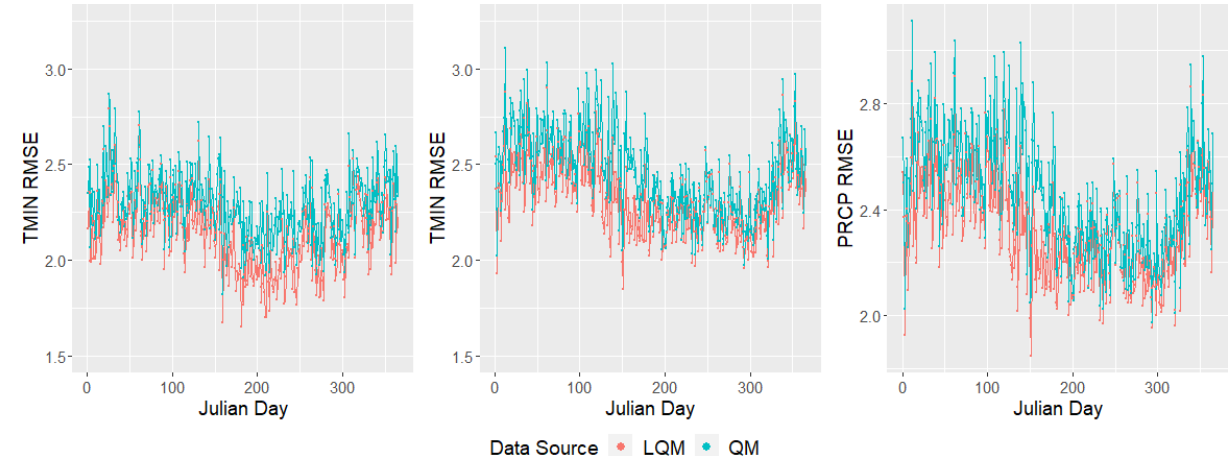
Figure 10. LQM RMSE (red) and QM RMSE (cyan) as a function of Julian day for TMAX (left), TMIN (middle), and PRCP (right). This figure was created using Wickham